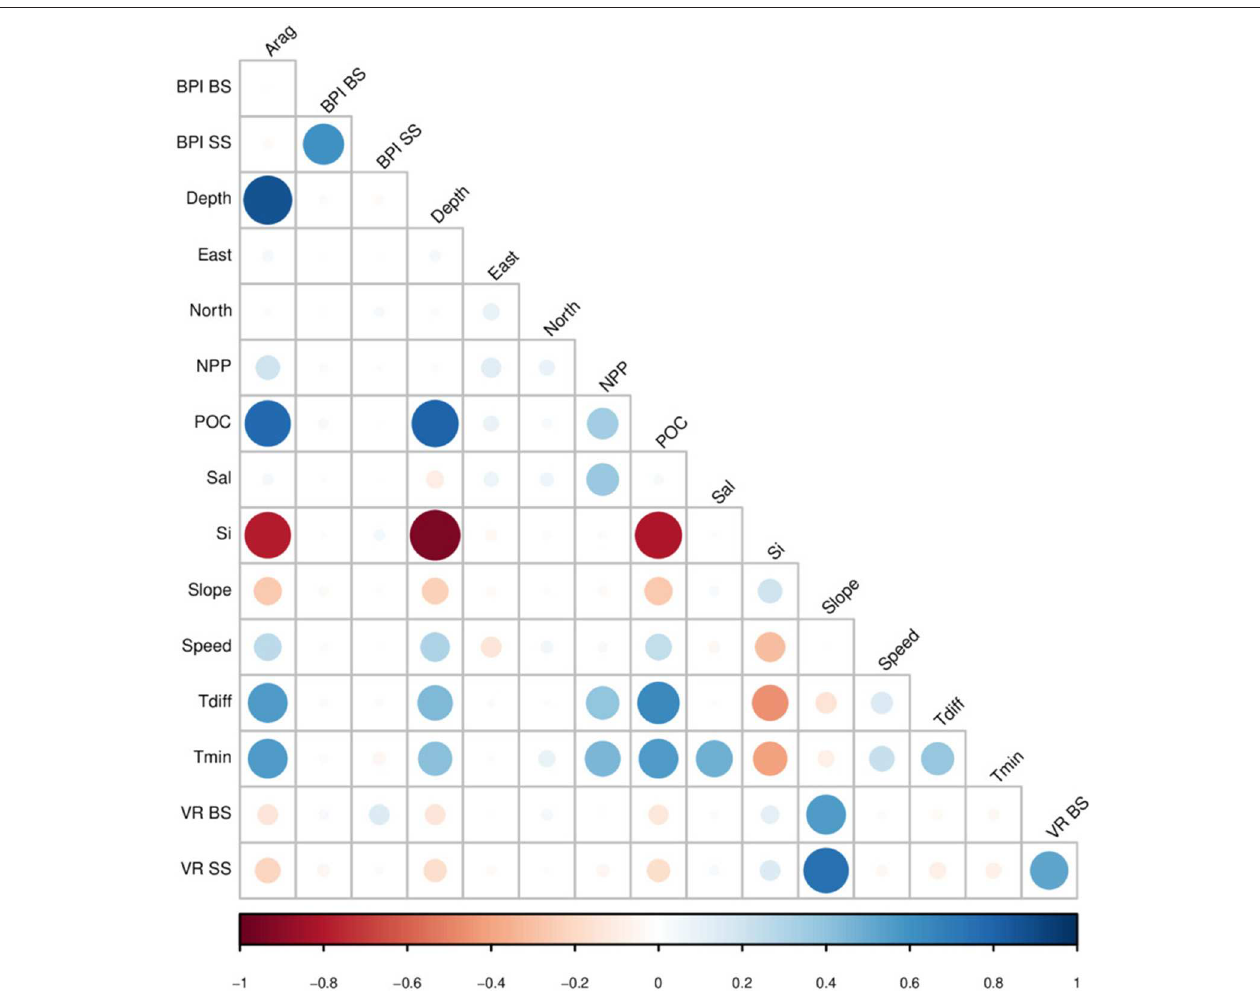
FIGURE 2 | Correlation matrix among the environmental variables used as predictor for the species distribution models: Aragonite saturation state (Arag), broad-scale bathimetric position index (BPI BS), small-scale bathimetric position index (BPI SS), bottom depth (Depth), eastness (East), northness (North), mean net primary productivity (NPP), particulate organic carbon (POC), mean salinity (Sal), silica concentration (Si), bottom slope (Slope), near-bottom current speed (Speed), temperature difference (Tdiff), minimum temperature (Tmin), broad-scale vector roughness, and small-scale vector roughness. Colors and size of circles indicate correlation values, from 1 (blue) to –1